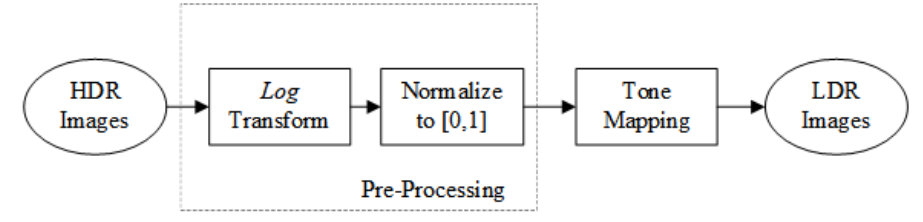
Figure 1. The pipeline of TM